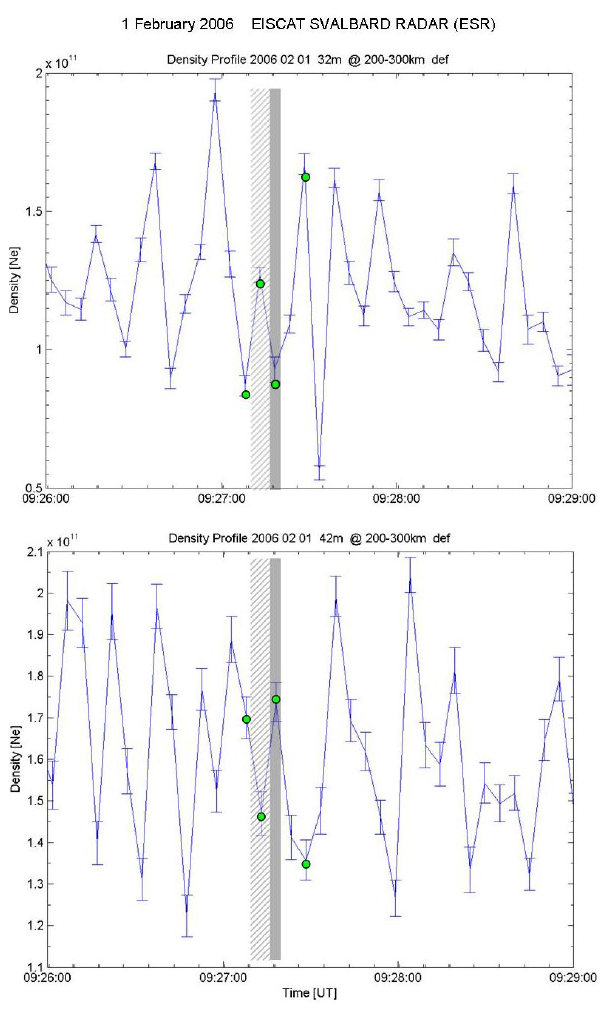
Fig. 6. Plot of the raw electron density versus time measured with the 32m antenna (upper figure) and the 42m antenna (lower fig- ure). The integration in height is 100km. Note the anti-correlation between the 32m and 42m during the time of interest, marked with green circles at ∼ 09:27:08UT, ∼ 09:27:13UT, ∼ 09:27:19UT and ∼ 09:27:28UT. The diagonally shaded area corresponds to data dumps taken when the REIMEI passes over the 32m antenna beam, while the shaded area indicates the start of the main ion step in the energy